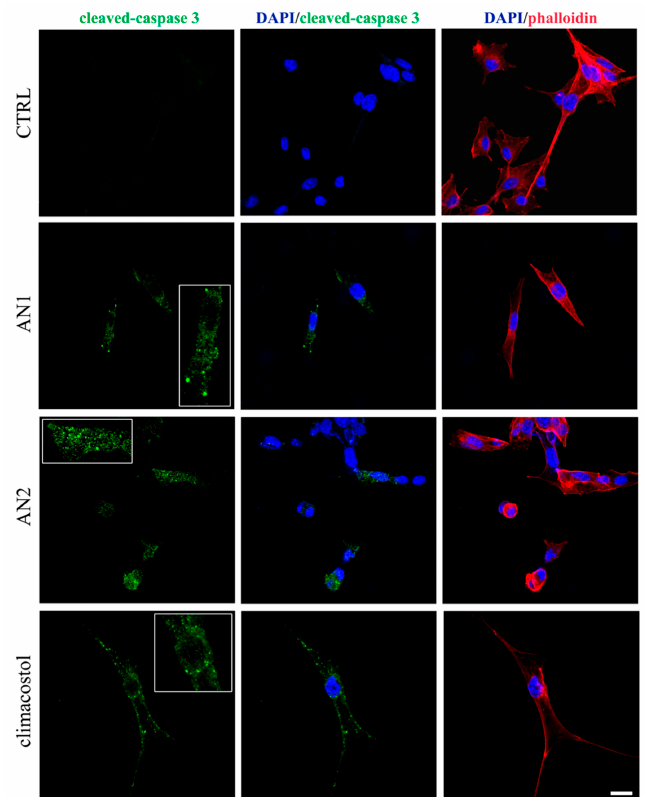
Figure 6. Induction of apoptosis by climacostol and its analogues (AN1, AN2) in melanoma cells. Immunofluorescence of cleaved-caspase 3 (punctate green pattern) in B16-F10 cells cultured in the presence of 30 µ g / mL of AN1, AN2, and climacostol or vehicle (CTRL) for 9 h. DAPI (blue) and phalloidin (red) were used for nuclei and cytoskeleton detection, respectively. Inserts represent enlarge image details. Scale bar = 20 µ m. Original picture from [31] and reproduced under the